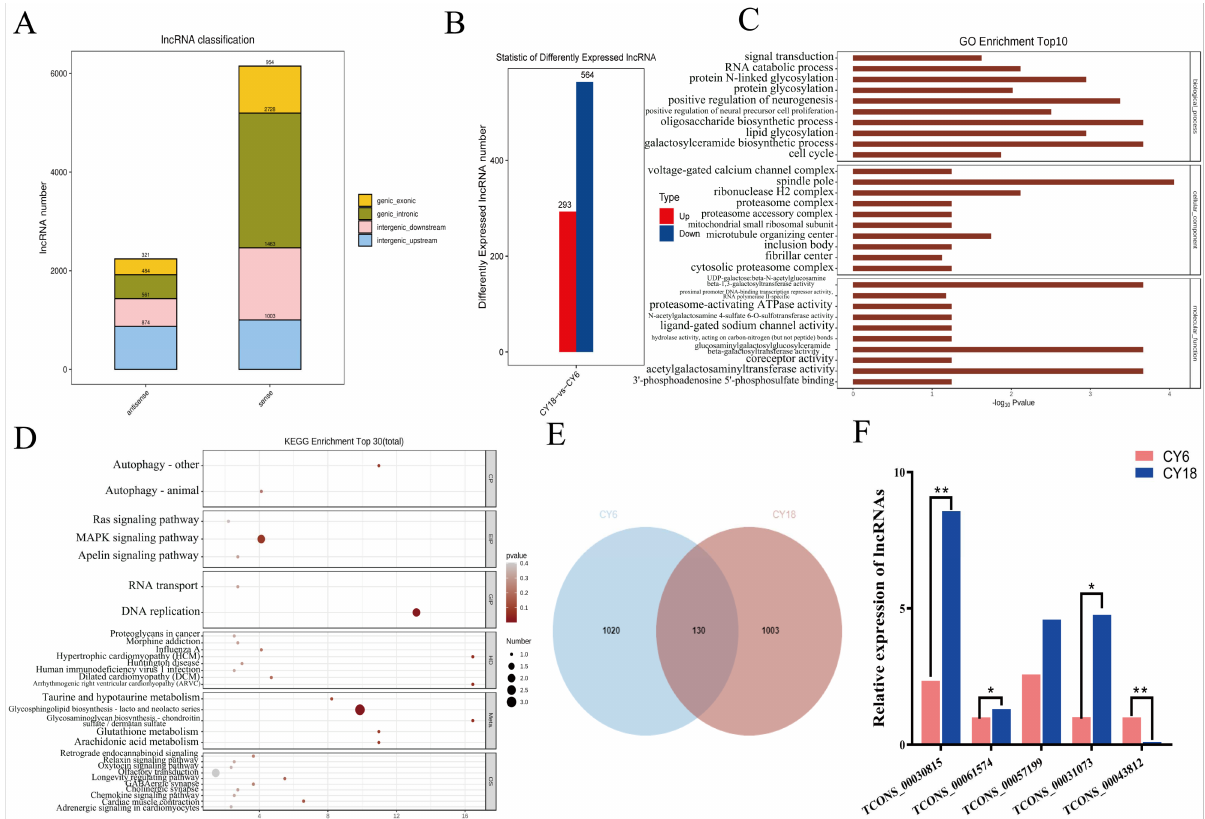
Figure 6. Identification and characterization of lncRNAs identified in the Longissimus dorsi muscle of cattle-yaks at different development stages: ( A ) classification of the identified lncRNAs in group CY6 and CY18; ( B ) number of up- and down-regulated differentially expressed lncRNAs (DELs); ( C ) GO analysis of DELs; ( D ) KEGG pathway analysis of DELs; ( E ) the common and specific m 6 A peaks on the lncRNAs in two groups; ( F ) the differentially expressed lncRNAs were testified using qRT-PCR. “**” p < 0.01, “*” p <